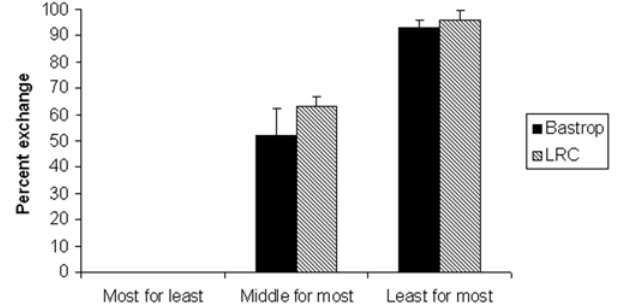
Figure 3. A comparison of the percent ( 6 SE) of exchange behavior of the Bastrop and LRC subjects, showing very similar behavior between the enculturated (LRC) and non-enculturated (Bastrop) chimpanzees. As expected, chimpanzees from neither group ever exchanged the most preferred item (grape at Bastrop, M&M at LRC) for a less preferred item (apple at Bastrop, cucumber at LRC), and subjects typically exchanged the majority of their least preferred items (carrot at Bastrop, cucumber at LRC) for their most preferred items (grape at Bastrop, M&M at LRC). However, chimpanzees from neither group exchanged all of their middle value items (cucumber at Bastrop, sweet potato at LRC) for their most preferred items, even though the higher value items were highly preferred in other contexts.